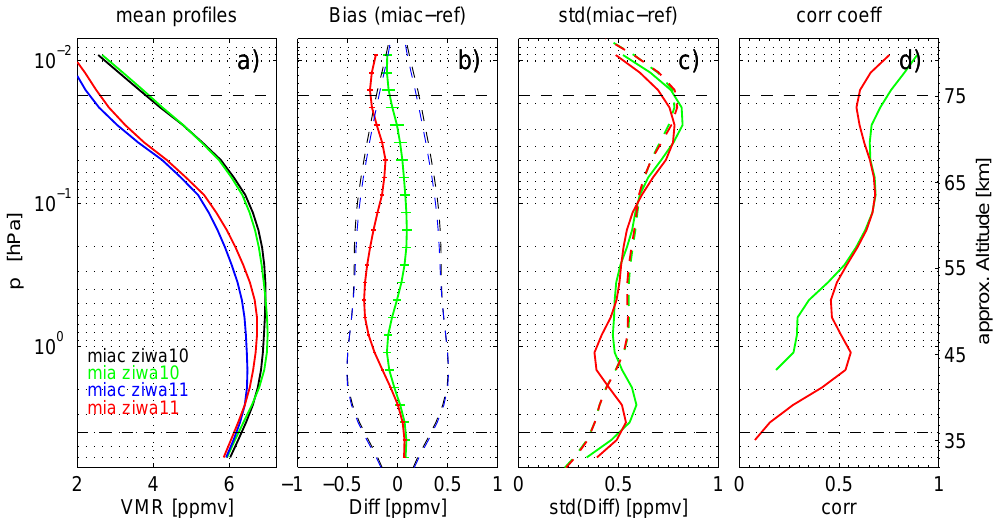
Fig. 8. Intercomparison MIAWARA-C – MIAWARA for Zimmerwald10 and for Zimmerwald11. (a) Mean coincident profiles for Zimmer- wald10 (MIAWARA: green, MIAWARA-C: black) and for Zimmerwald11 (MIAWARA: red, MIAWARA-C: blue). (b) Bias (solid) with standard error (horizontal) with respect to MIAWARA (Zimmerwald10: green, Zimmerwald11: red) together with the estimated systematic error of MIAWARA-C (black dashed). (c) Standard deviation of differences (solid) and combined random error of the instruments (dashed). (d) Correlation coefficients. All plots use MIAWARA/MIAWARA-C data with AoA > 0.5. The dashed horizontal lines indicate the reliable altitude range (AoA >